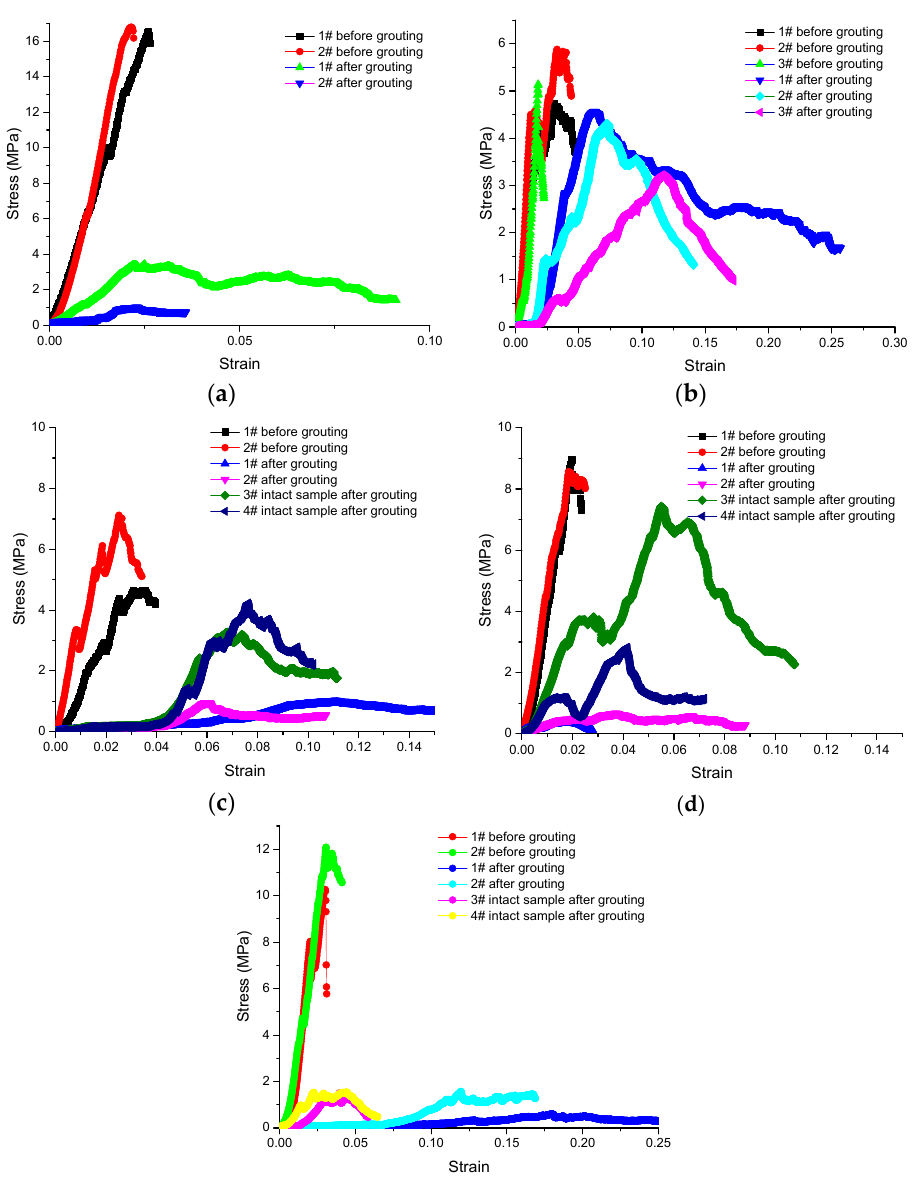
Figure 9. Uniaxial compression stress strain curves for samples before and after grout impregnation with five different grouts. The elastic modulus reflects the capacity of a sample to resist deformation. Uniaxial compressive strength (UCS) and peak strain both reflect the capacity of the sample to resist failure. Pre-peak absorption strain energy (PASE) [18] is the energy that causes sudden failure of a rock. ( a ) Grouting with P.O 425R W/C = 0.7; ( b ) Grouting with MP364 R/C = 1:1; ( c ) Grouting with silica sol S/C = 1:0; ( d ) Grouting with silica sol S/C = 6:1; ( e ) Grouting with silica sol S/C = 4:1.